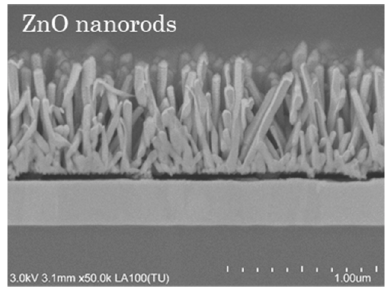
Figure 1. SEM image of ZnO nanorods deposited on an ITO substrate.